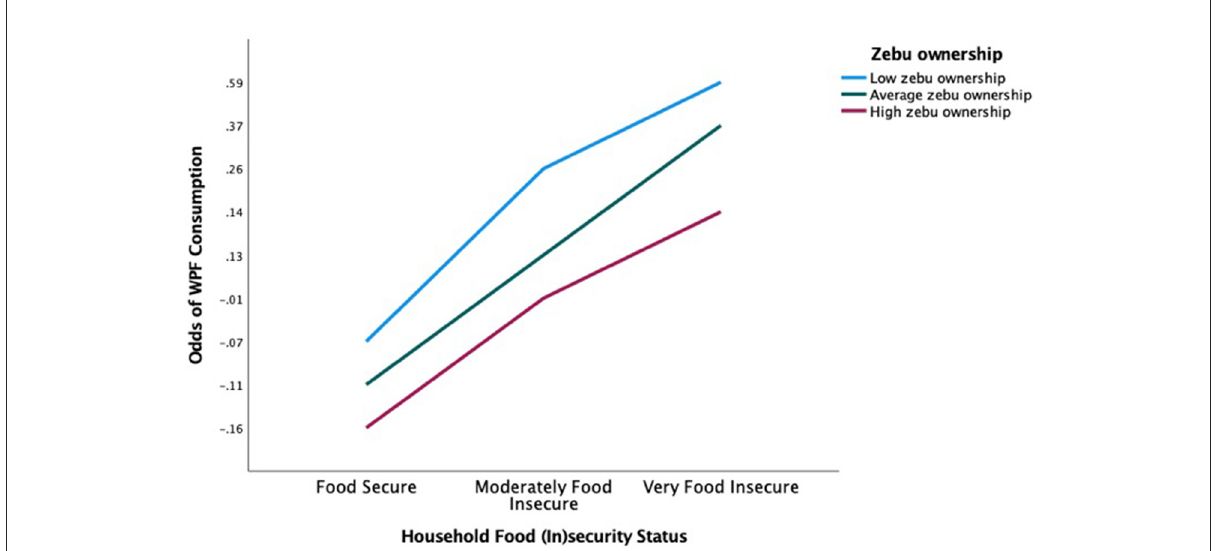
FIGURE8 Interaction of number of zebus owned and food (in)security level on odds of WPF consumption. This plot of simple slopes displays the odds of WPF consumption among the three food (in)security categories on the x-axis, and a separate line for each level of zebu owned (mean, 1 SD above, 1 SD